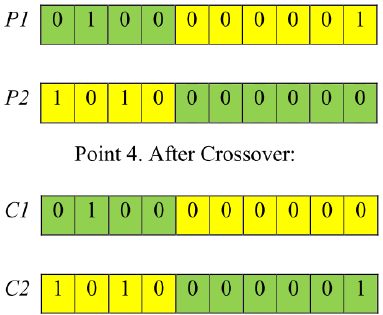
Figure 2. Example of the effective one-point crossover.